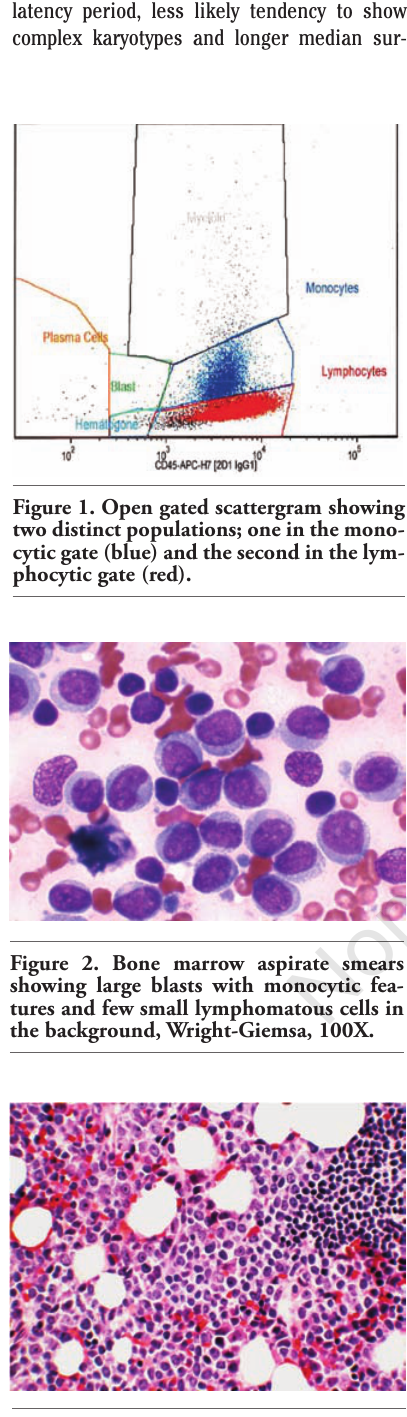
Figure 3. Hypercellular bone marrow biop- sy showing involvement by sheets of blasts and neoplastic lymphoid cells, Hematoxylin & Eosin,